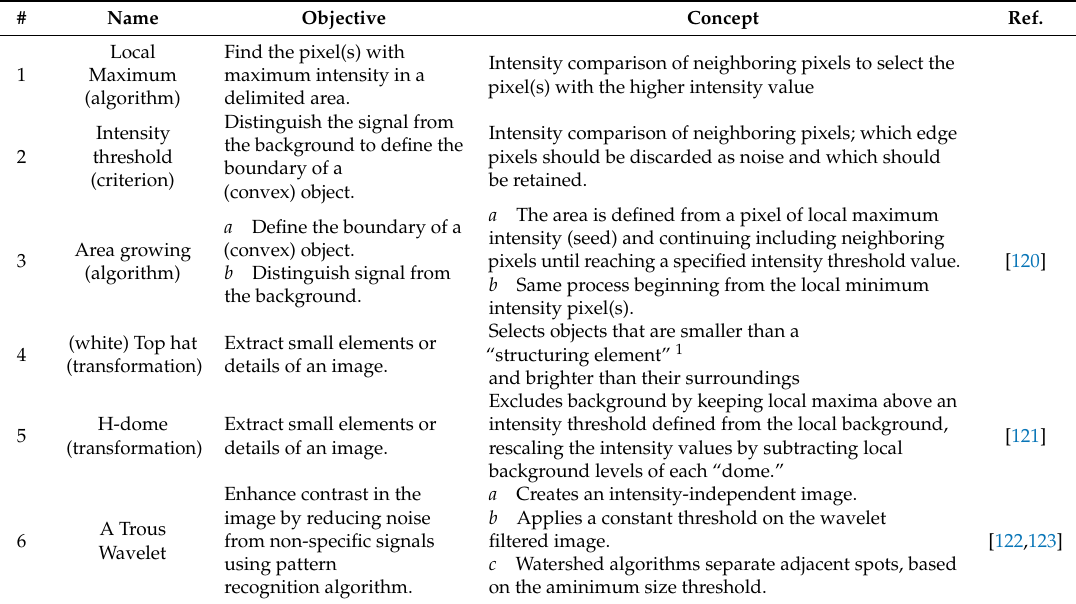
Table 3. Nuclei detection: criteria, algorithms, and